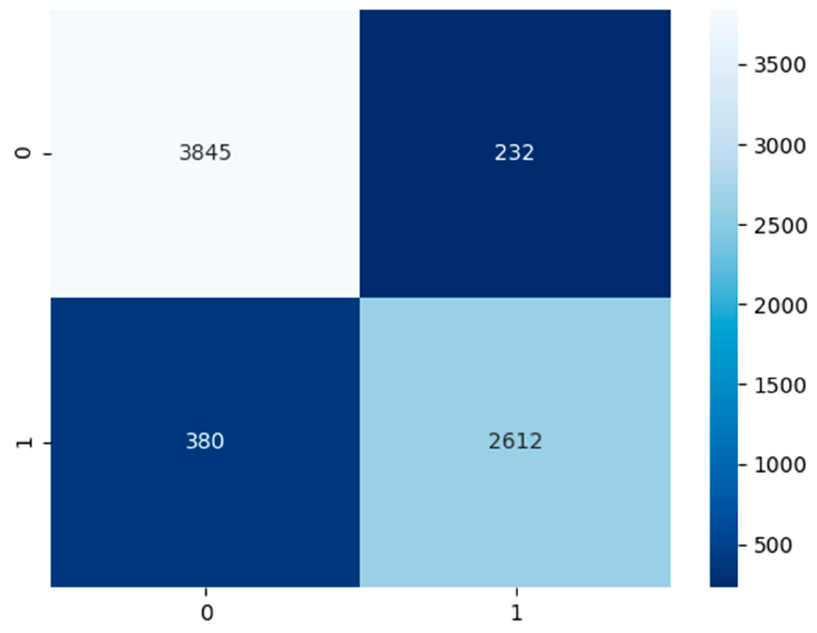
Figure 8. Non-COVID-19 CXR Model Confusion Matrix (Need to change the caption for Figure 8)